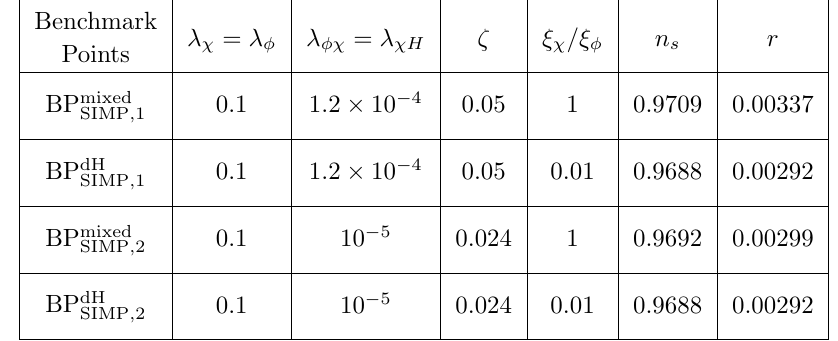
Table 2 . Input parameters for our benchmark points, denoted as black points in (cid:12)gures 4 and 5. In this case, m Z 0 is also (cid:12)xed to m Z 0 = 0 : 235 GeV. The superscript represents the in(cid:13)ation type; for example, BP mixed (BP dH ) is the benchmark point where mixed (dark Higgs) in(cid:13)ation is SIMP ; 1 SIMP ; 1 allowed.